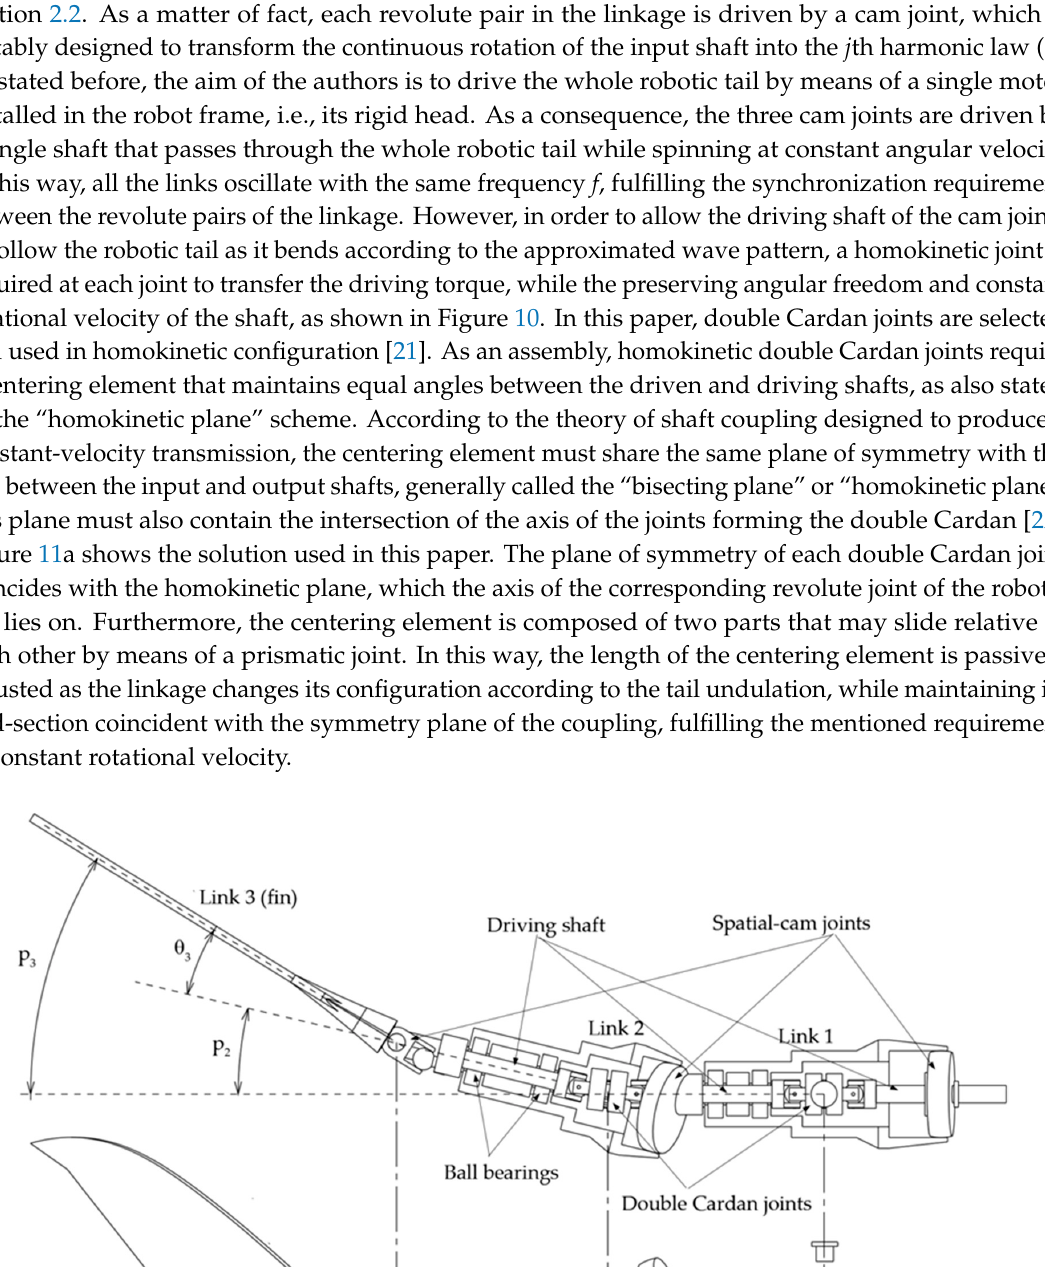
Figure 11. ( a ) Double Cardan joint: unbent tail (left), bent tail (right). ( b ) Spatial cam joint geometry. In order to size the spatial cam joints and generate the harmonic laws (9), the following equations must be solved: